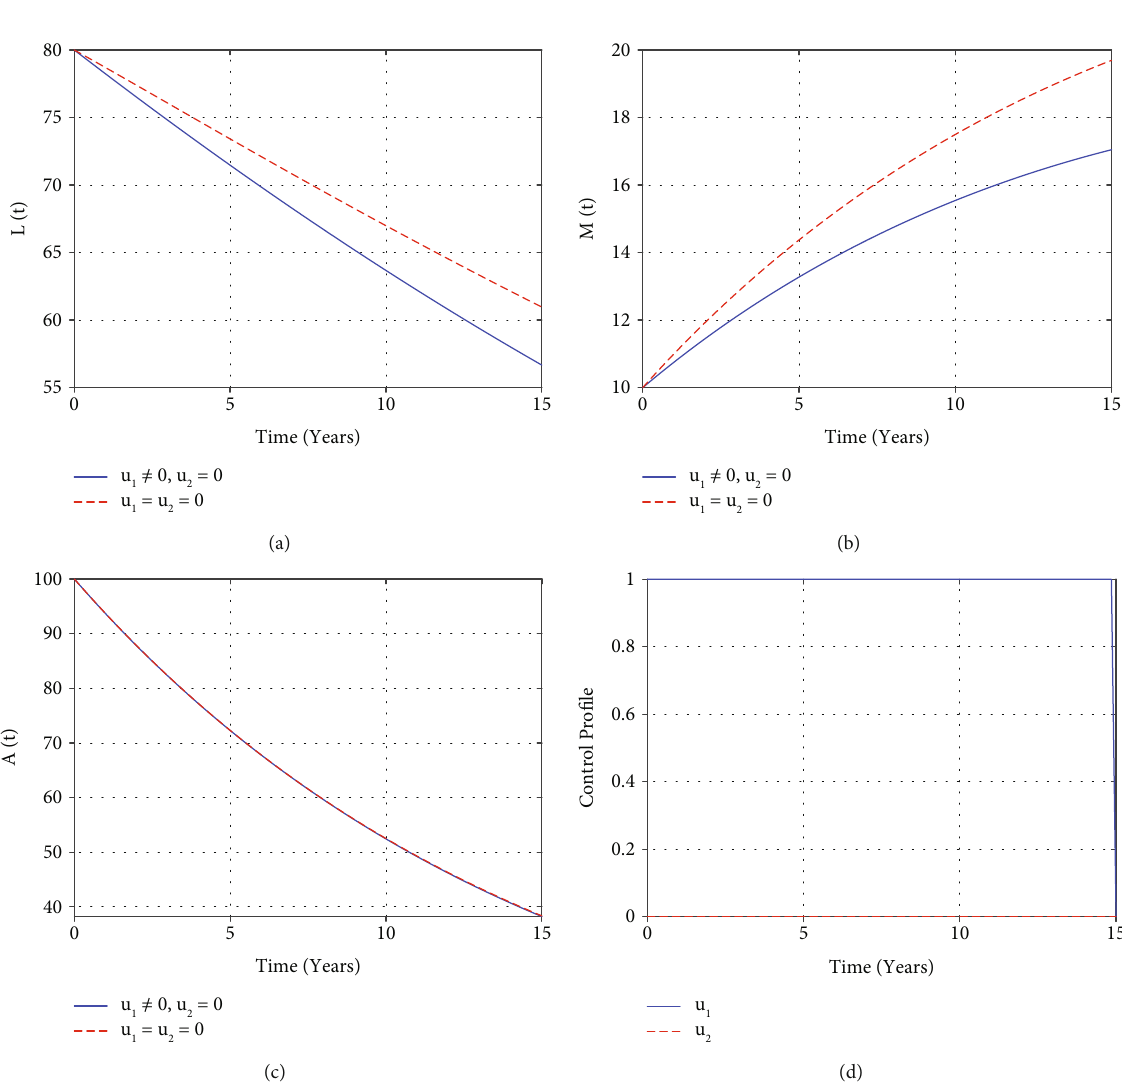
Figure 2: Time series of di ff erent risky population proportions with their corresponding control pro fi le for implementation of Strategy